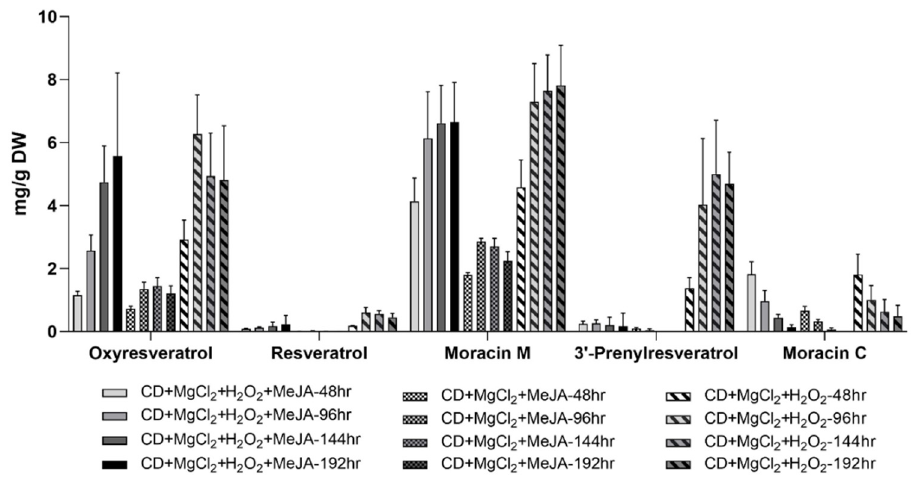
Figure 6. Time course of the yield of stilbenes and aryl benzofurans in the medium of white mulberry hairy root culture line U ‐ D2 after treatment with different elicitors. Yields are expressed in mg/g DW of root tissue. Values are the average of four biological replicates and error bars represent standard deviation.